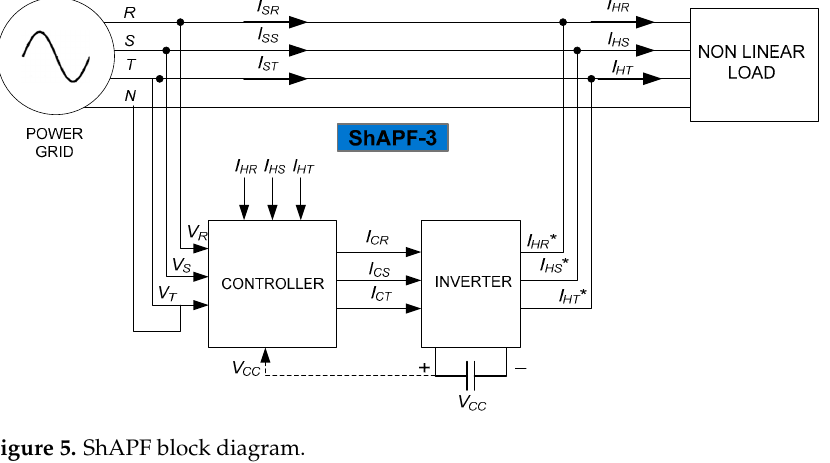
Figure 5. ShAPF block